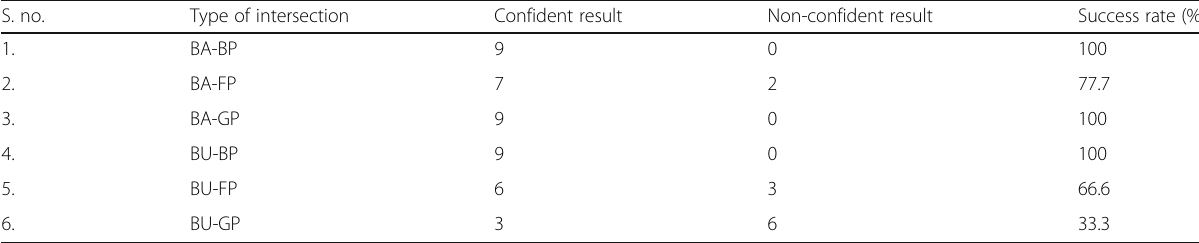
Table 1 Results of criterion 1 observed under Nikon A1 confocal microscope S.